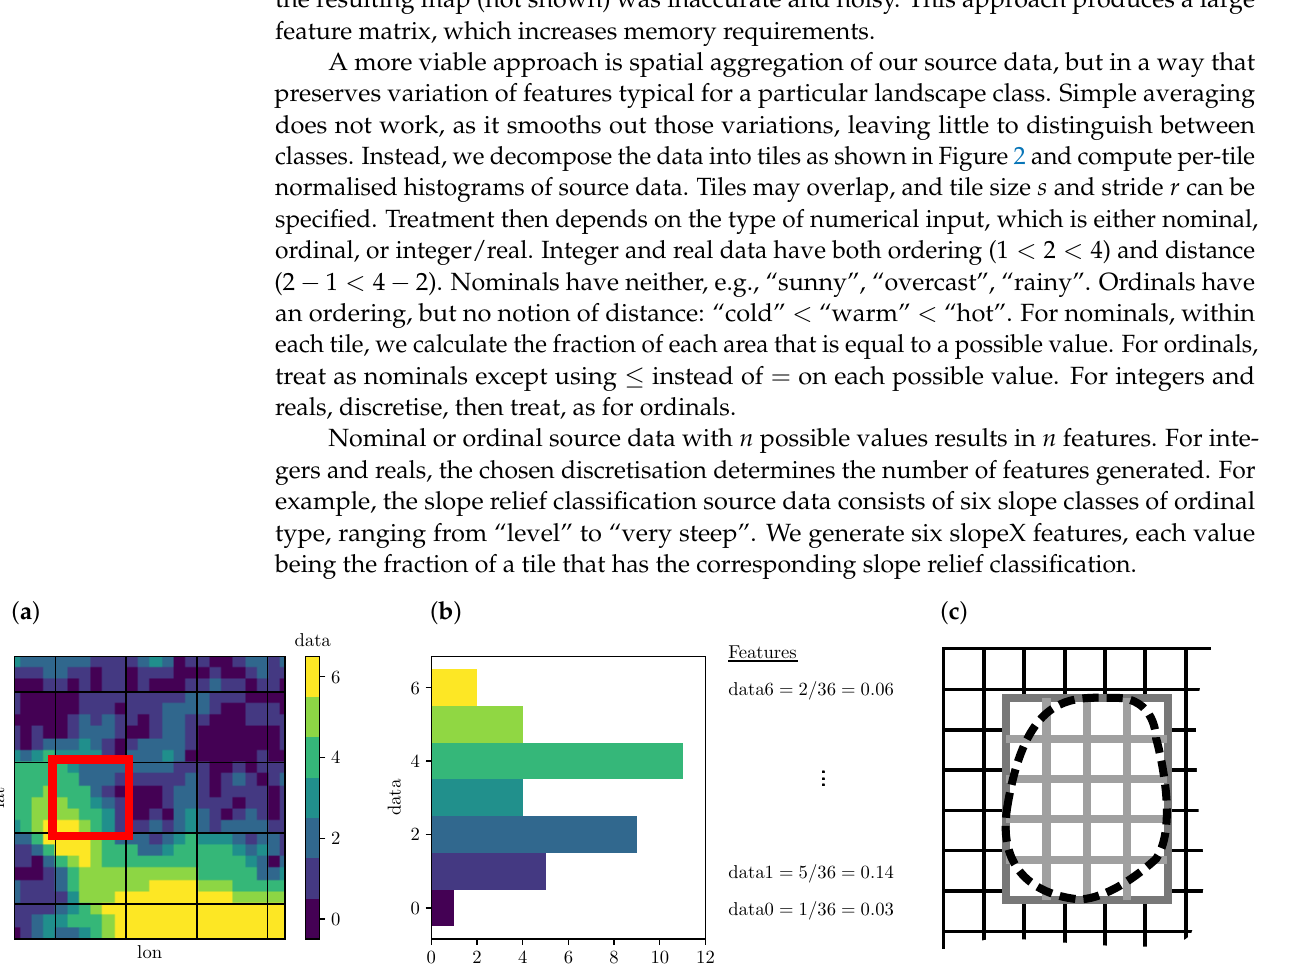
Figure 2. Spatial feature aggregation. ( a ) We decompose the source data into tiles of size s fraction of each area that is equal to a possible value. In other words, we compute per-tile normalised histograms of source data. In this example, we use s = 6 and a generic field of “data” ranging 0 to 6, sorted into seven bins, which results in seven features “data0” . . . “data6”. ( c ) The bounding box of a landclass training region determines the training grid (gray), which generally differs from the grid (black) used for predicting the final map. This helps to identify overfitted models. See text for